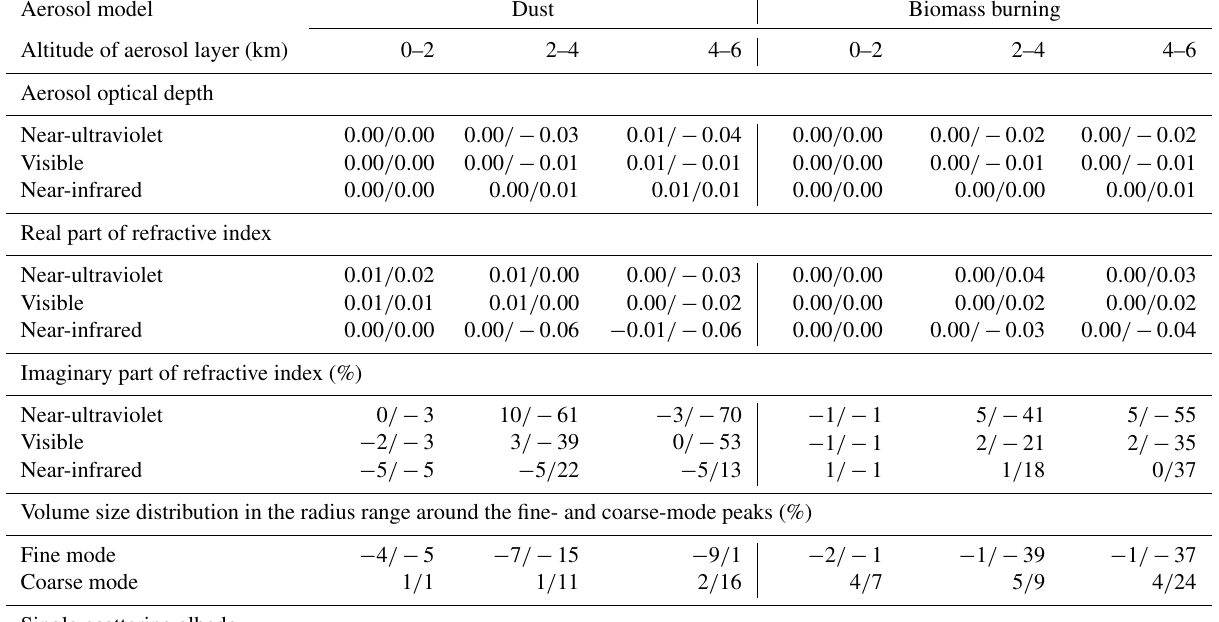
Table 4. Means of the retrieval errors for the almucantar and principal plane geometries. Aerosol model Dust Altitude of aerosol layer (km) Aerosol optical